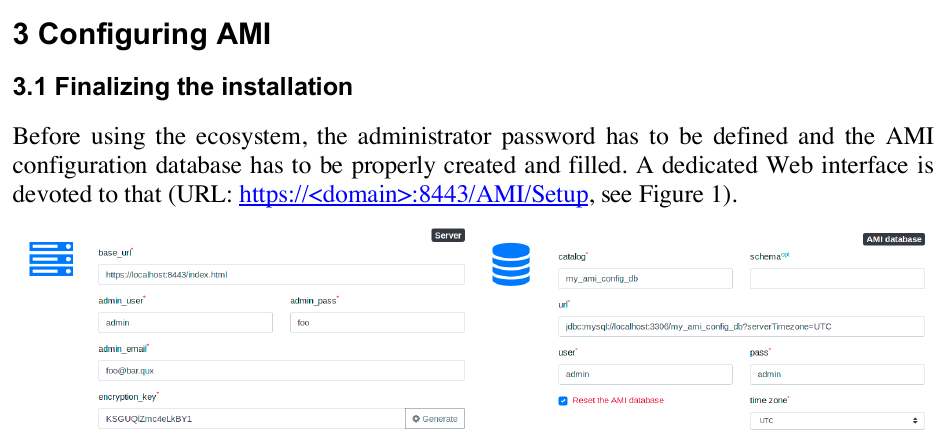
Fig. 1. Screenshot of the installation finalization interface (URL: https://<domain>:8443/AMI/Setup). From this point, AMI is accessible from URL: https://<domain>:8443/.